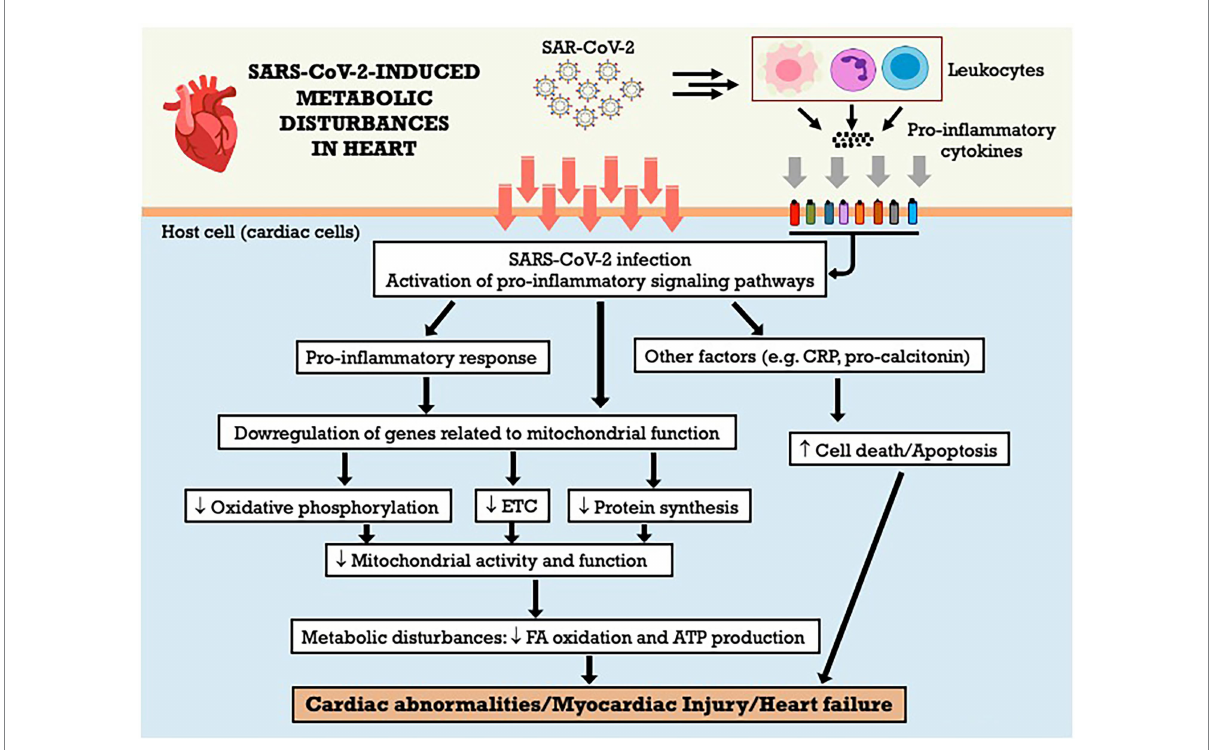
FIGURE 4 SARS-CoV-2-induced metabolic disturbances in heart. ATP adenosine triphosphate; CRP, C-reactive protein; ETC, electron transport chain; FA, fatty